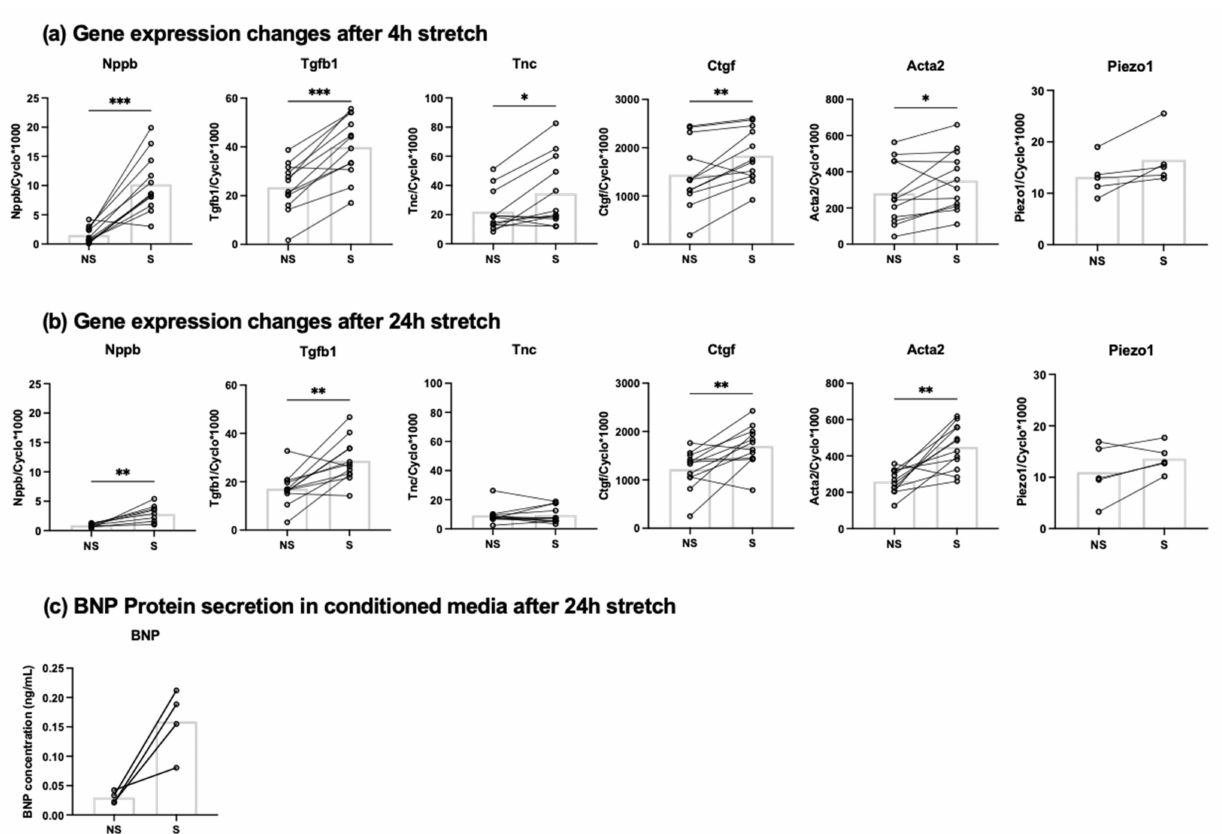
Figure 1. Relative mRNA expression levels of Nppb, Tgfb1, Tnc, Ctgf, Acta2, and Piezo1 in cardiac fibroblasts exposed to 10% 1 Hz cyclic stretch (S) or non-stretched (NS) conditions for 4 h ( n = 5–12) ( a ) or 24 h ( n = 5–12) ( b ). BNP-protein concentration in conditioned media from stretched and non-stretched cardiac fibroblasts ( n = 4) ( c ). * p < 0.05; ** p < 0.01; *** p < 0.001. Bar indicates